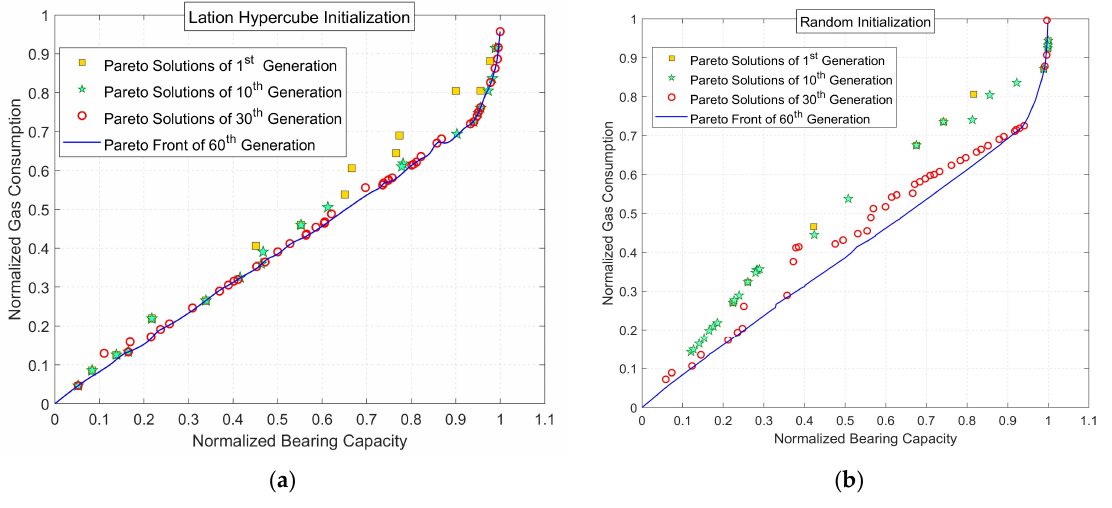
Figure 11. Pareto solutions obtained using ( a ) Latin hypercube and ( b ) random initialization.